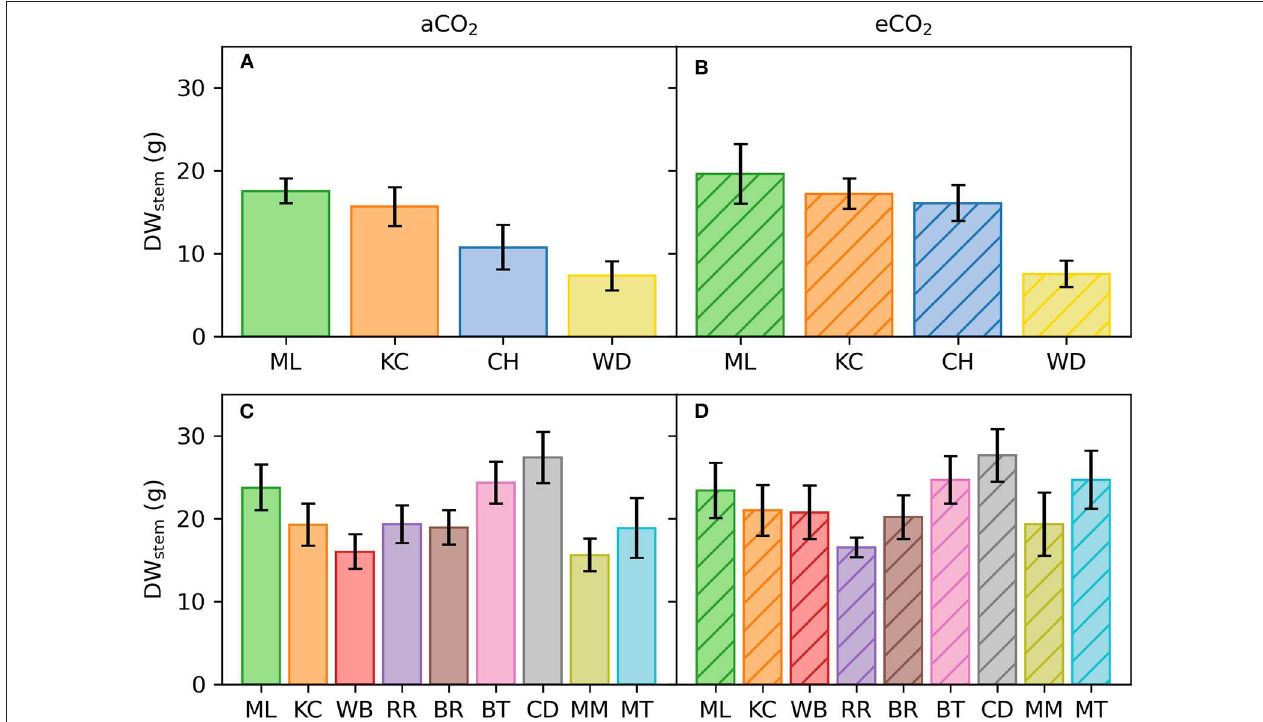
FIGURE 6 | Mean stem dry weight (g) of E. grandis at the end of Experiment 1 and 2. Seedlings ( n = 3–7 per provenance) were grown in ambient (aCO 2 ; left ) and elevated CO 2 (eCO 2 ; right ). Colors in (A,B) represent the four selected provenances of Experiment 1. The nine selected provenances of Experiment 2 are shown in (C,D) . Error bars represent 1SE.